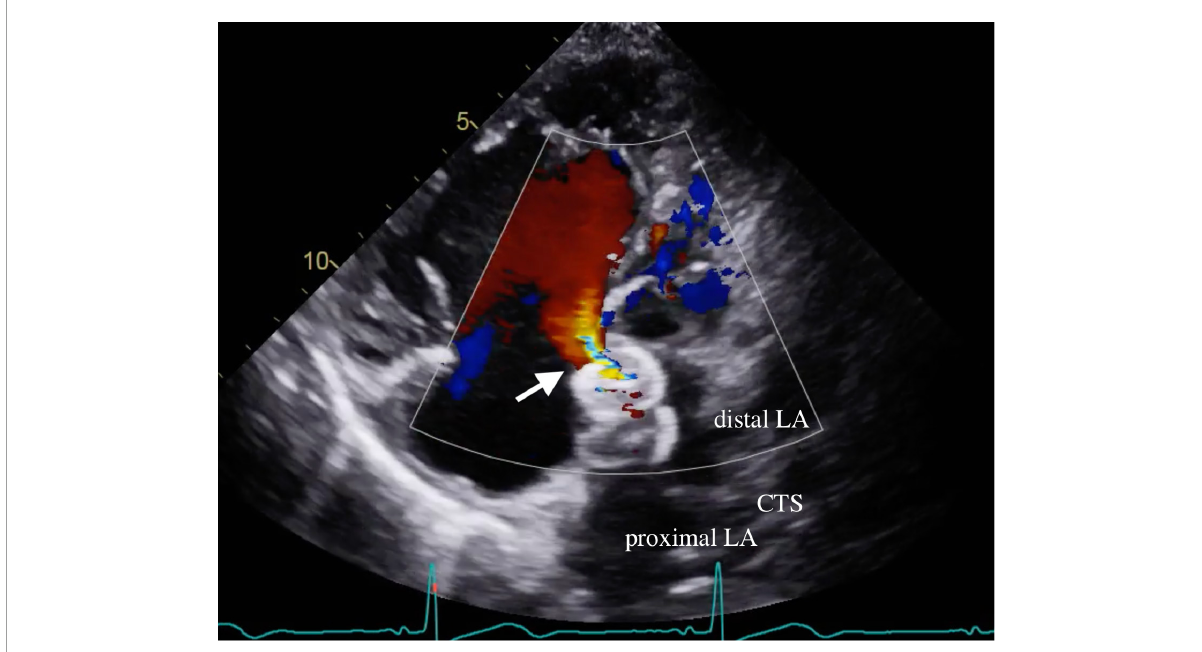
FIGURE2 Residual ASD shunt. Transthoracic echocardiography demonstrated residual shunting (arrow) through the waist of the ASD device. ASD denotes atrial septal defect; CTS denotes cor triatriatum sinister; LA denotes left